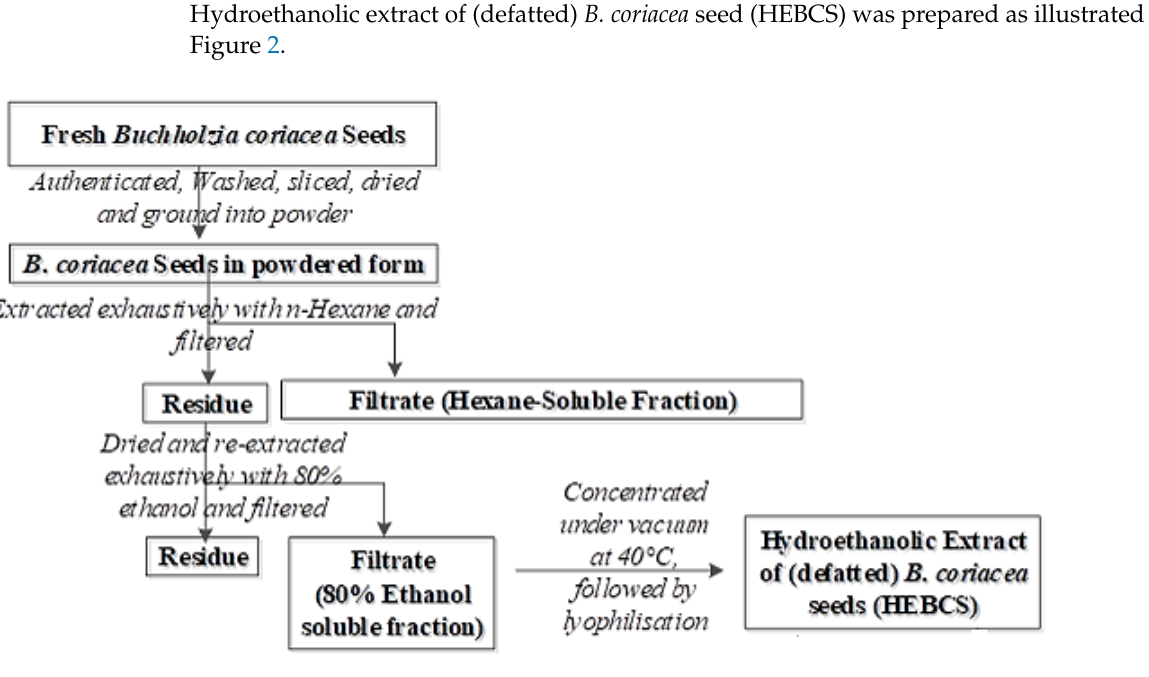
Figure 2. Steps in the preparation of hydroethanolic extract of Buchholzia coriacea seeds adapted from Ore et al. [24]